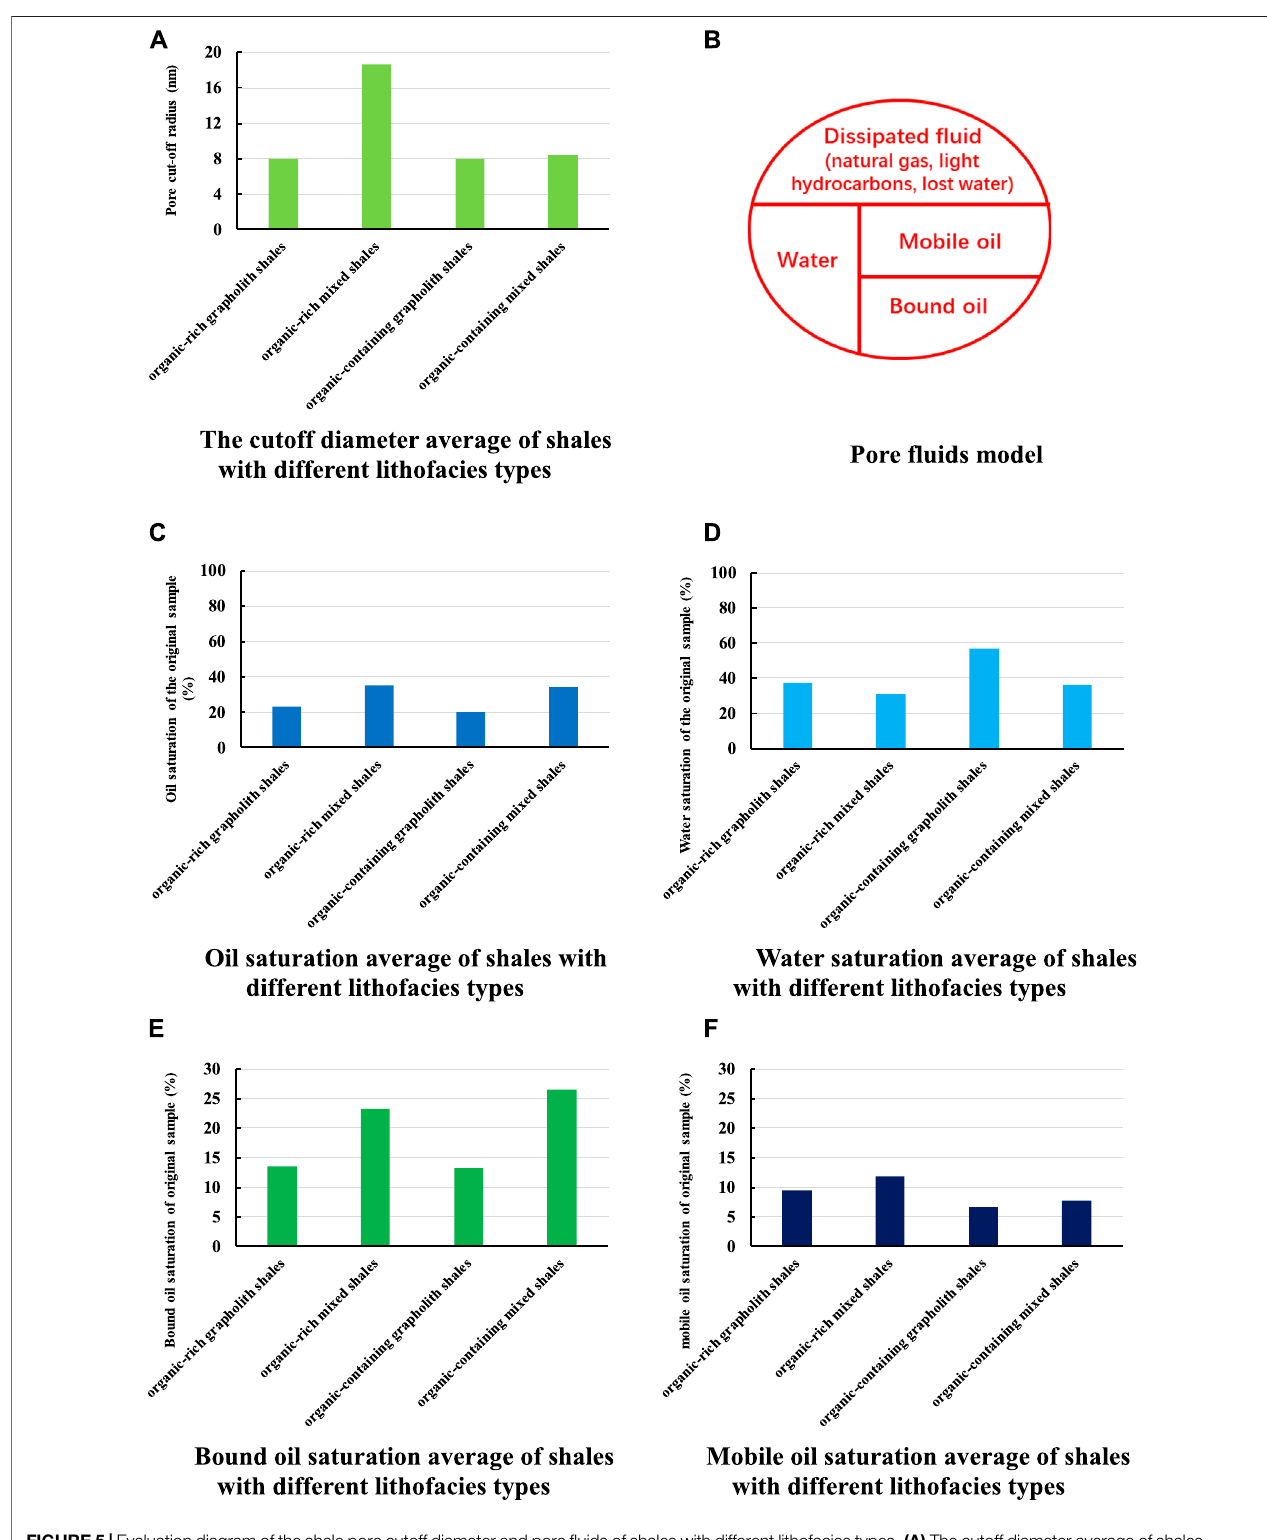
Frontiers in Earth Science |